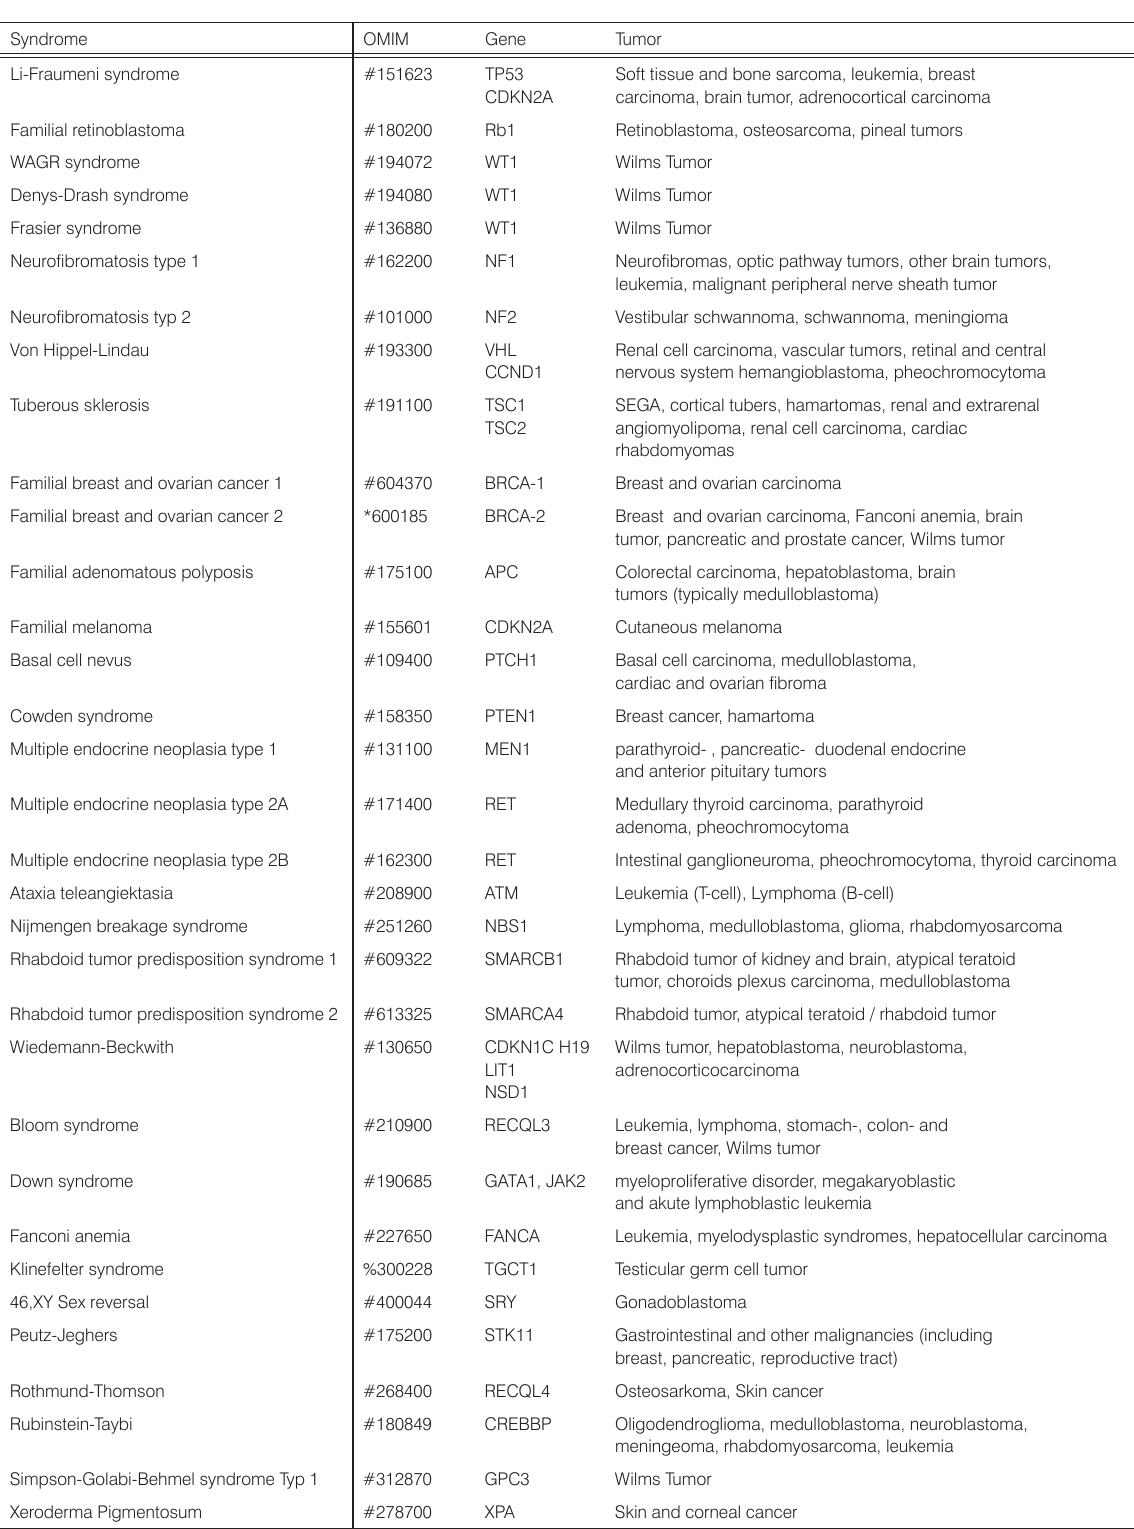
Table 5. Cancer predisposition syndromes [ 7 , 34 , 35